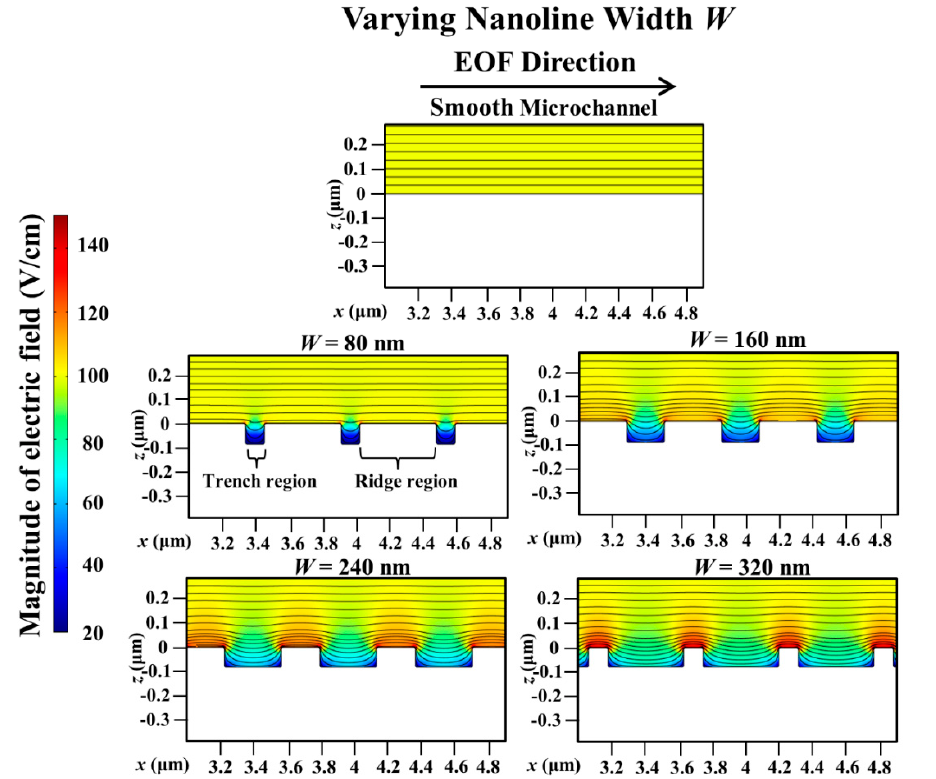
Figure 6. Simulated electric field distribution in microchannel with varying nanoline width W , in comparison to smooth microchannel. Sodium bicarbonate (NaHCO 3 ) concentration was fixed at 1.0 mM, and nanoline orientation angle θ , period P , and depth D were fixed at 45°, 400 nm, and 90 nm, respectively. As W increases, the distortion in trench subsides leading to stronger field strength.